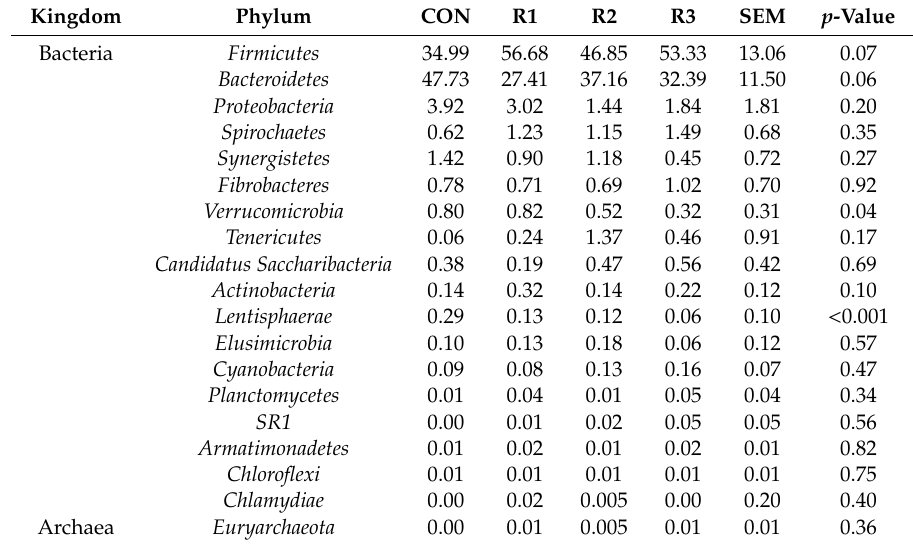
Table 3. Composition and relative abundance at the phylum level of the rumen microbial communities in goats fed with corn and ramie ( n = 4)